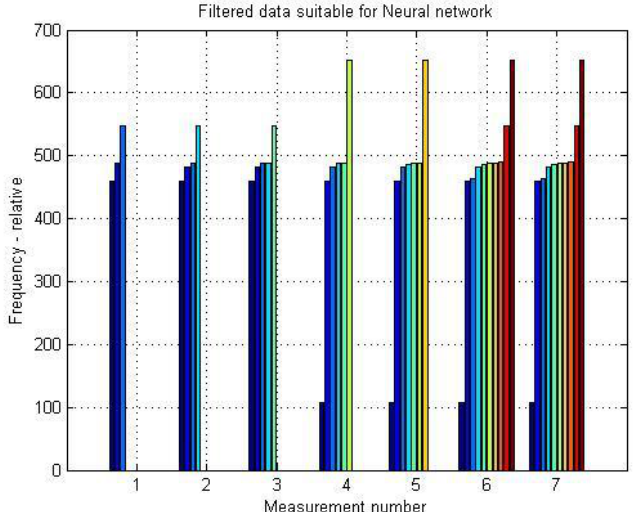
Figure 9. Input data for the neural network. Numbers of major values corresponding to individual points are present in each measurement.